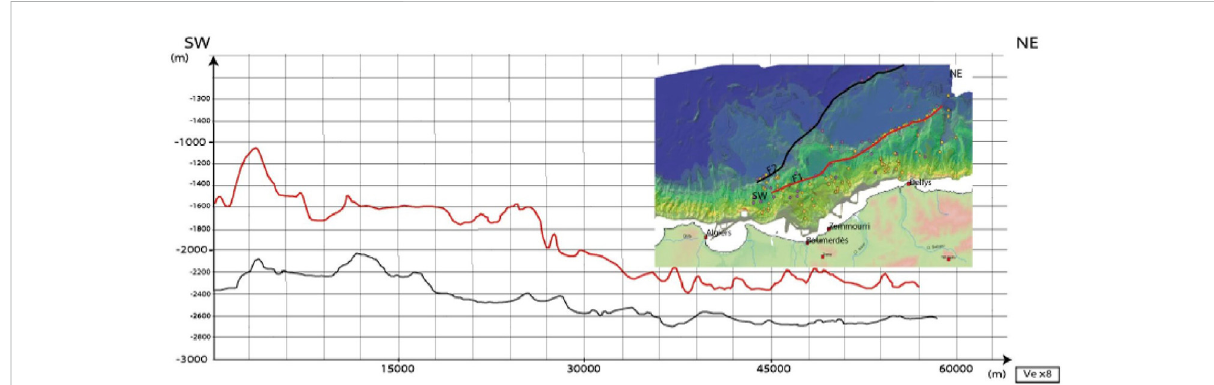
FIGURE 7 Along-strike topographic pro fi les following the two main concave slope breaks (continuous morphological scarps) identi fi ed by alignments of knickpoints(yellowandpurplecirclesforknickpointsidenti fi edinthecanyonsandtheinter fl uves,respectively).Uppercurve(red)istakenatthefoot of the scarp interpreted by Déverchère et al. (2005; 2010) as the blind thrust ramp (F1) in the prolongation of the 2003 rupture plane. Lower curve (black) is where several studies have reported the existence at depth of a south-dipping thrust ramp (F2; Déverchère et al., 2005; Domzig et al., 2006; Strzerzynski et al., 2010). Vertical exaggeration (Ve) of 8. See text for details.